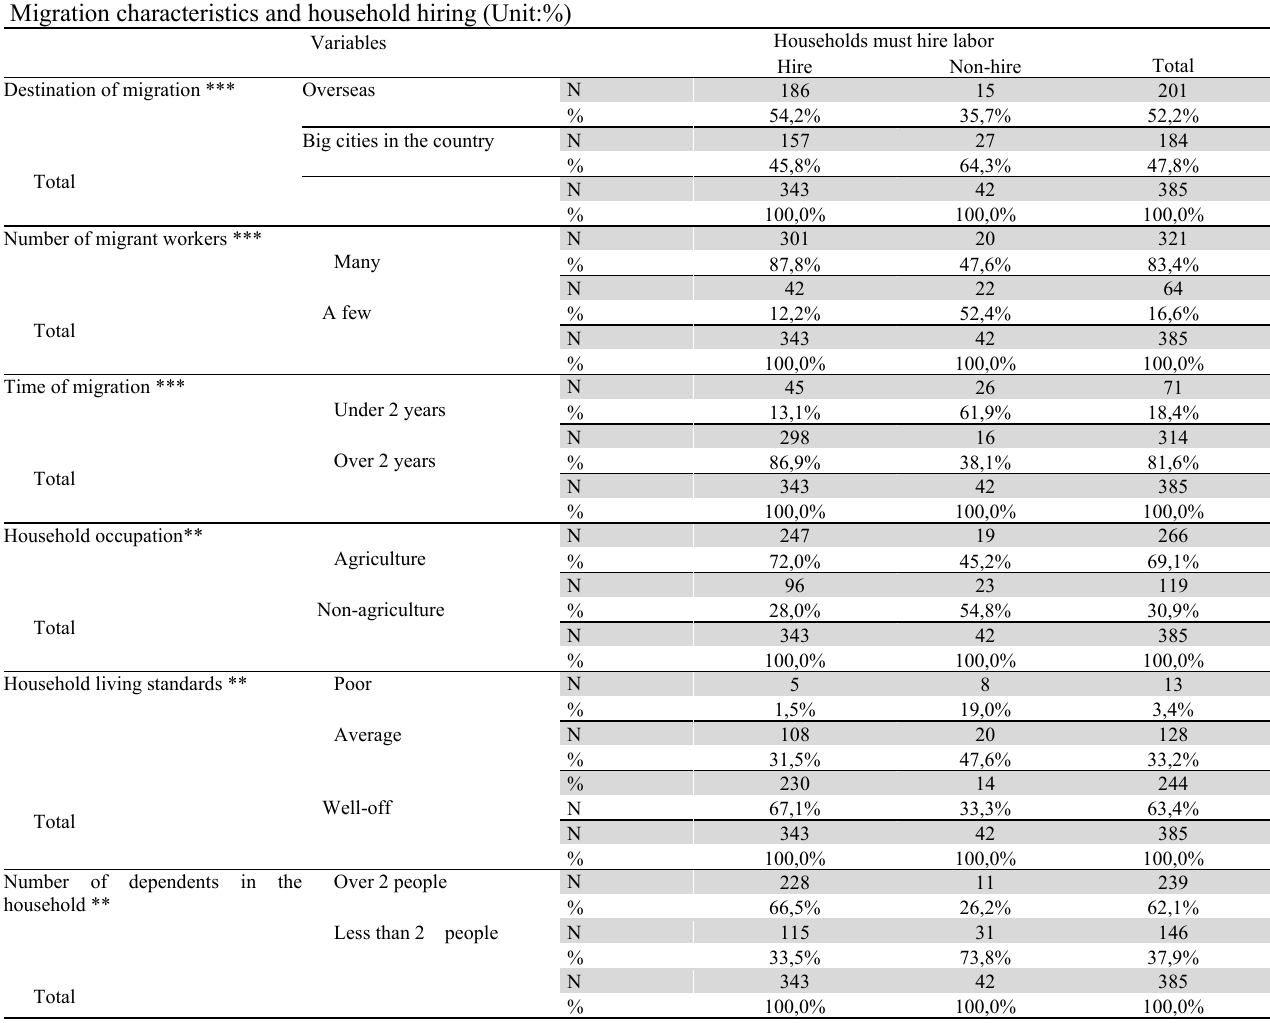
Migration characteristics and household hiring (Unit:%) Variables Households must hire labor